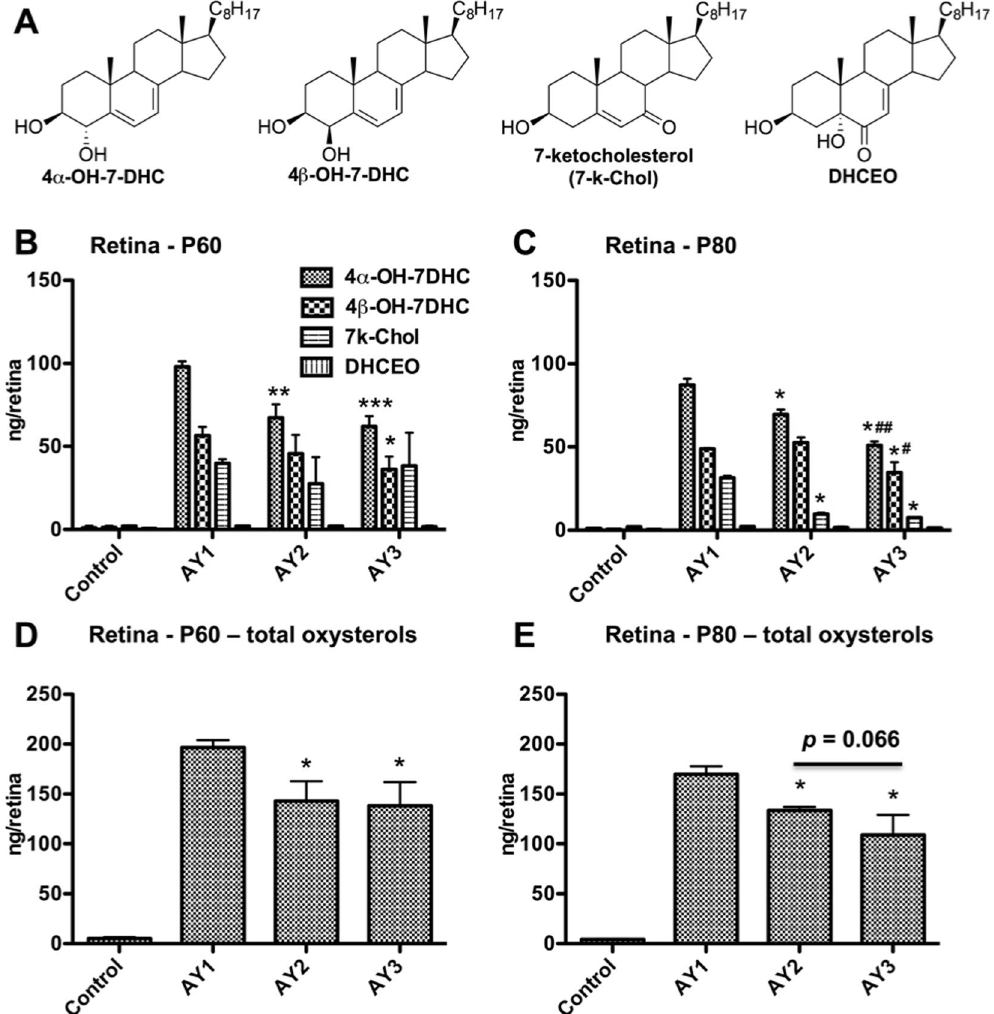
Figure 4. Quantification of selected 7DHC-derived oxysterols in neural retina as a function of dietary regimen and postnatal (PN) age. Oxysterols were quantified by UHPLC-MS/MS as described in Methods; values given in ng/retina. ( A ) Oxysterol structures (see inset, panel B, for key): 4 α -hydroxy-cholesta-5,7-dien-3 β -ol (4 α -OH- 7DHC), 4 β -hydroxy-cholesta-5,7-dien-3 β -ol (4 β -OH-7DHC), 7-ketocholesterol (7k-Chol), and 3 β ,5 α - dihydroxycholest-7-en-6-one (DHCEO). Individual oxysterol levels at ( B ) PN 60 days and ( C ) PN 80 days. Total oxysterol levels at ( D ) PN 60 days and ( E ) PN 80 days. For PN 60 days rats, N = 4 for each group. For PN 80 days rats, Control group, N = 4; AY1 group, N = 2; AY2 group, N = 3; AY3 group, N = 3. Significance levels (Student’s t -test): * p < 0.05; ** p < 0.005, and *** p < 0.001 for comparison of AY1 vs . AY2 and AY3 values; # p < 0.05 and ## p < 0.005 for comparison of AY2 vs . AY3